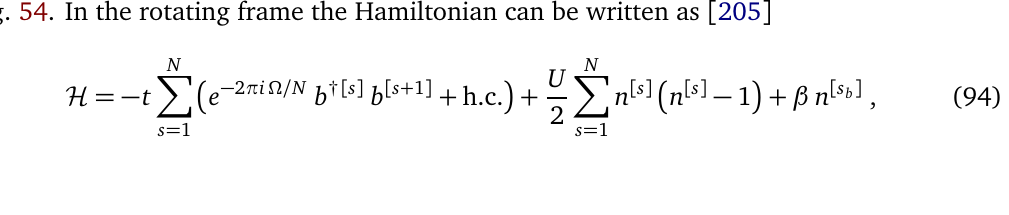
/ ¯ ∂ 〉 (red) as a function of the e o links